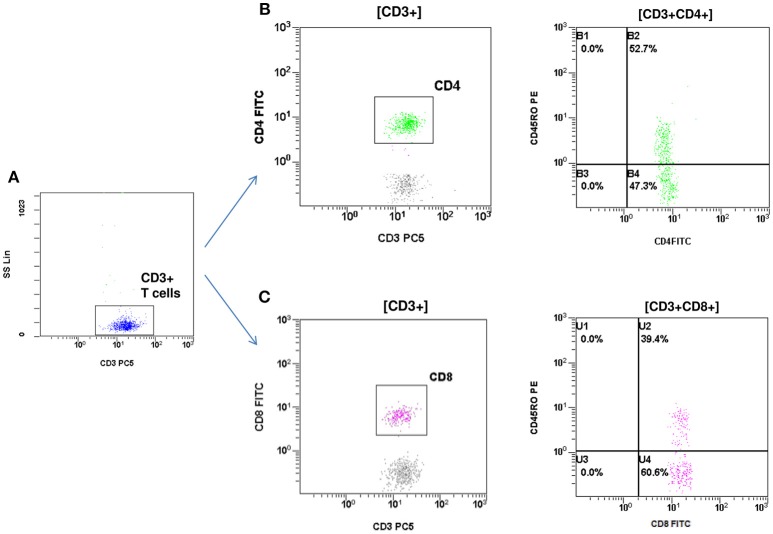
Flow cytometric assessment of memory T helper and memory T cytotoxic cells. (A) T cells were gated by CD3 and side scatter (SS). (B) T helper memory cells: CD3+CD4+CD45RO+. (C) T cytotoxic memory cells: CD3+CD8+CD45RO+.The percentage of memory T helper (52.7%) and memory T cytotoxic cells (39.4%) were elevated compared to reference age values (7–20 and 2–15% respectively).